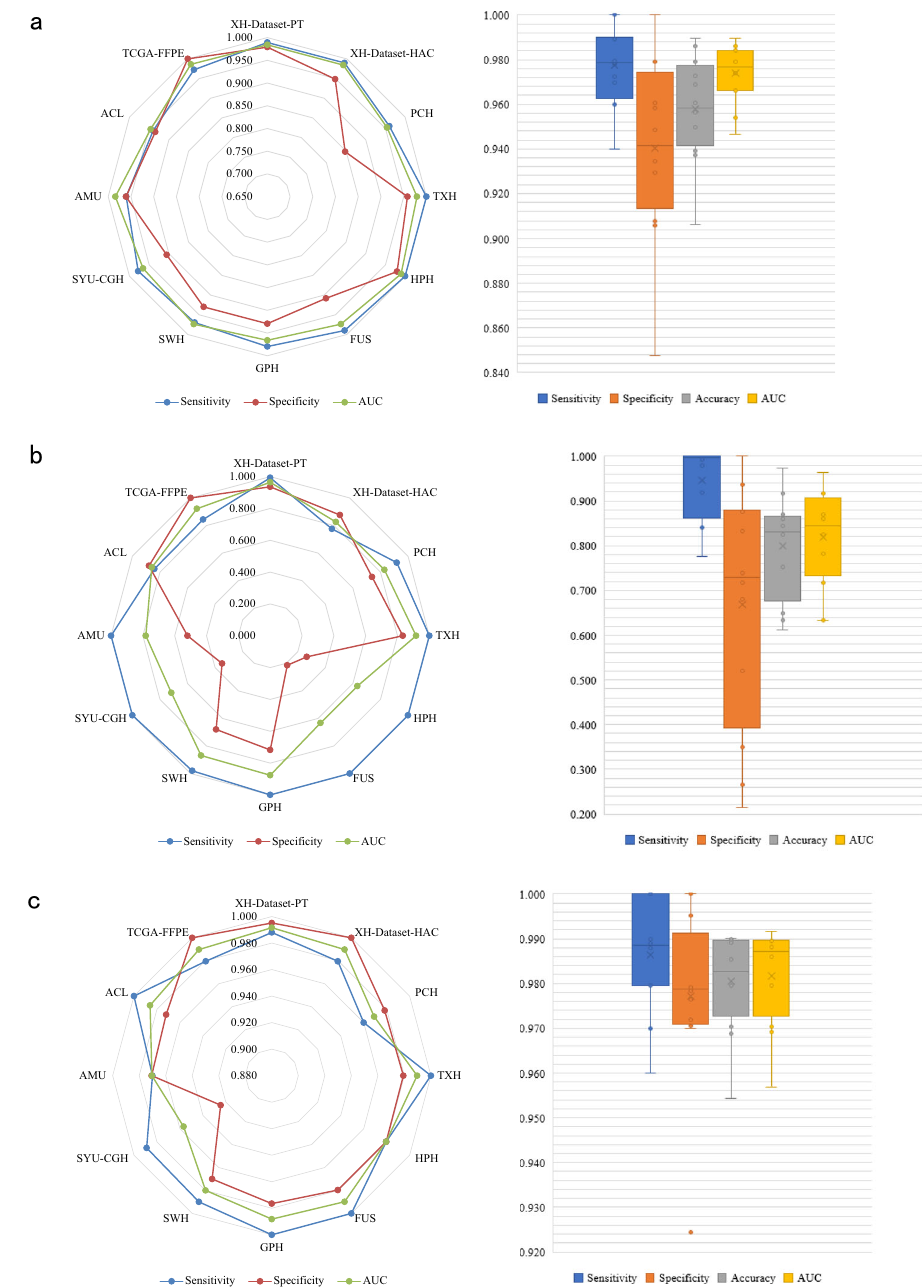
Fig. 3 The results of patient-level CRC recognition. Patient-level comparison of a Model-10%-SSL, b Model-10%-SL, and c Model-70%-SL on 12 independent data sets from Dataset-PT. Left: Radar maps illustrate the sensitivity, speci fi city, and area under the curve (AUC) of three models on 12 centers. Right: Boxplots show the distribution of sensitivity, speci fi city, accuracy, and AUC of the three models in these centers. The boxes indicate the upper and lower quartile values, and the whiskers indicate the minima and maxima values. The horizontal bar in the box indicates the median, while the cross indicates the mean. The circles represent data points, and the scatter dots indicate outliers. The average AUC and standard deviation (sample size = 12) are calculated for each model, and the Wilcoxon-signed rank test (sample size/group = 12) is then used to evaluate the signi fi cant difference of AUCs between two models. Two-sided P values are reported, and no adjustment is made. Model-10%-SSL vs. Model-10%-SL: AUC: 0.974 ± 0.013 vs. 0.819 ± 0.104, P value = 0.002; Model-10%-SSL vs. Model-70%-SL: 0.974 ± 0.013 vs. 0.980 ± 0.010, P value = 0.117. The data points are listed in Supplementary Data Extended SSL vs. SL experiment of lung and lymph node 294,912 lymph node images including tumor and benign tissue cancer . In order to demonstrate the utility of SSL on other were obtained from PatchCamelyon dataset (Pcam) 37 . Simi- larly, SSL was trained on a small number of labeled images and pathological images, the experiments of SSL and SL on lung and a large number of unlabeled images (for which labels are known lymph node were performed. 15,000 lung images of three but ignored during training), and compared with SL (Tables 3 classes: adenocarcinoma, squamous cell carcinoma, and benign and 4). tissue were obtained from LC25000 dataset (Lung) 36 , and the